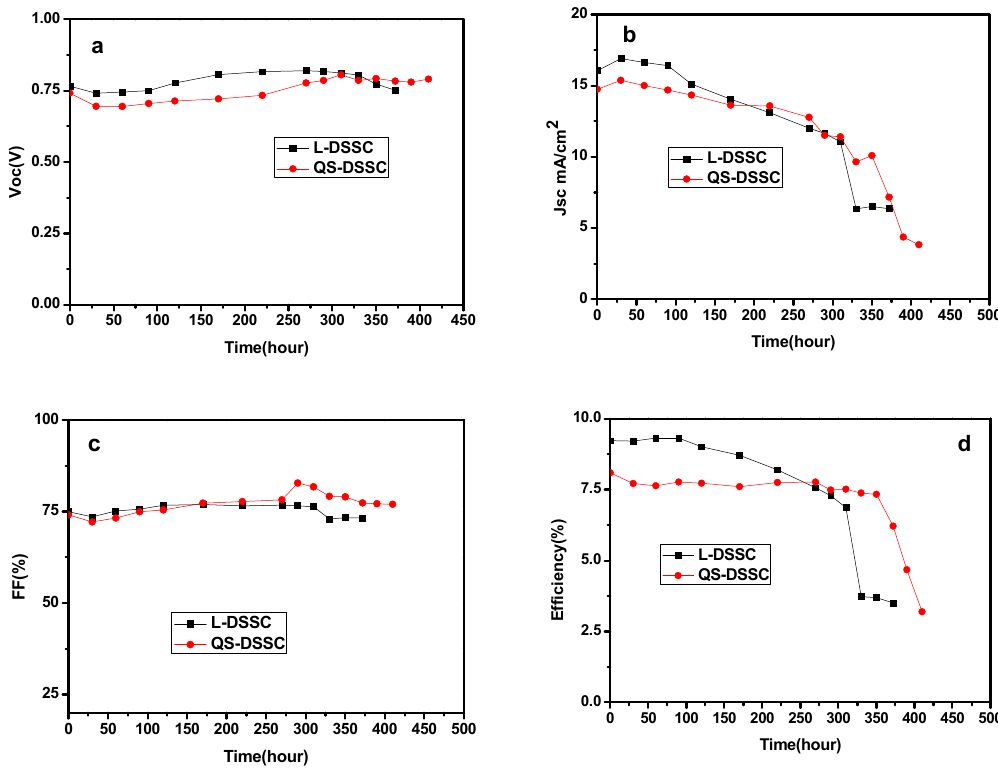
Figure 14. Normalized photoelectric performance of the QS-DSSC and L-DSSC versus time under outdoor conditions: ( a ) V OC , ( b ) J SC , ( c ) FF, ( d ) η .